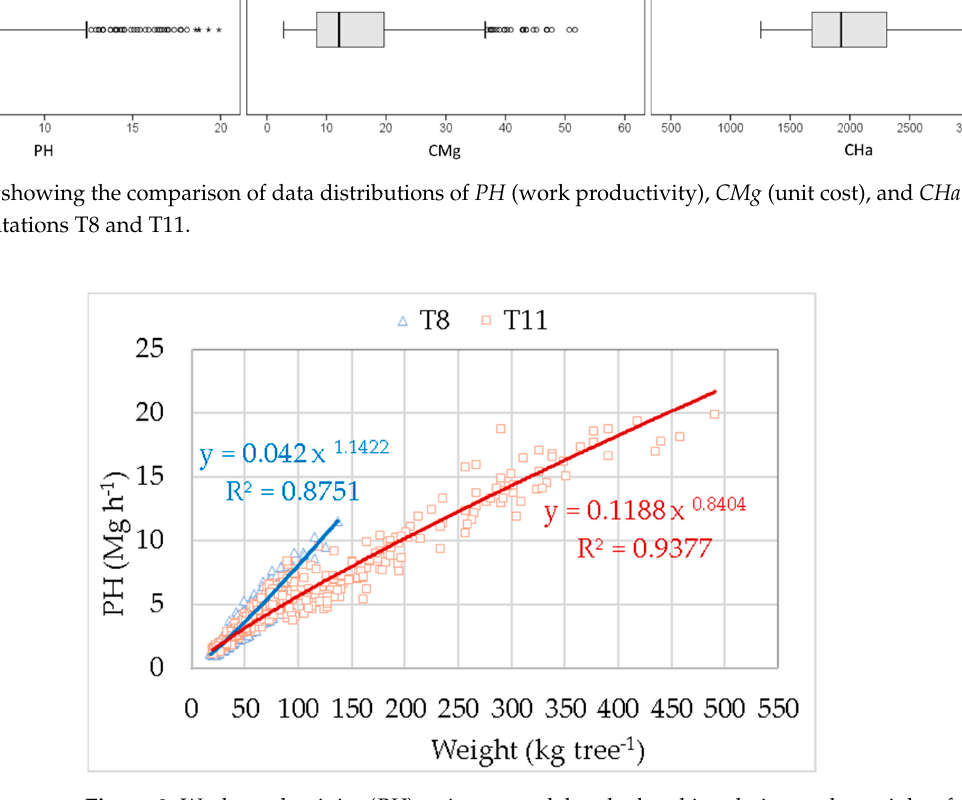
Figure 7. Box plots showing the comparison of data distributions of PH (work productivity), CMg (unit cost), and CHa (cost per hectare) in plantations T8 and T11.